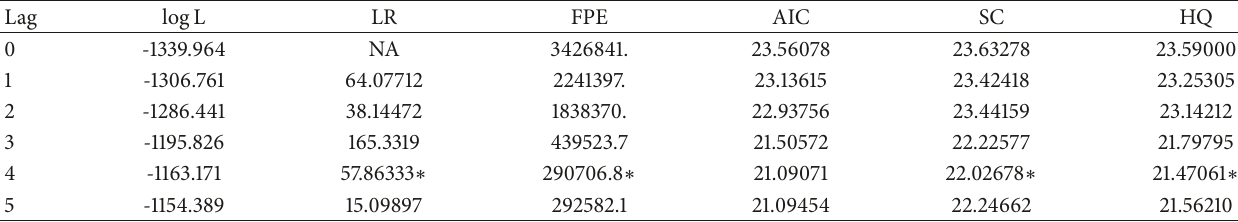
Table 3: Determine Lag Intervals for Endogenous with Lag Length Criteria.